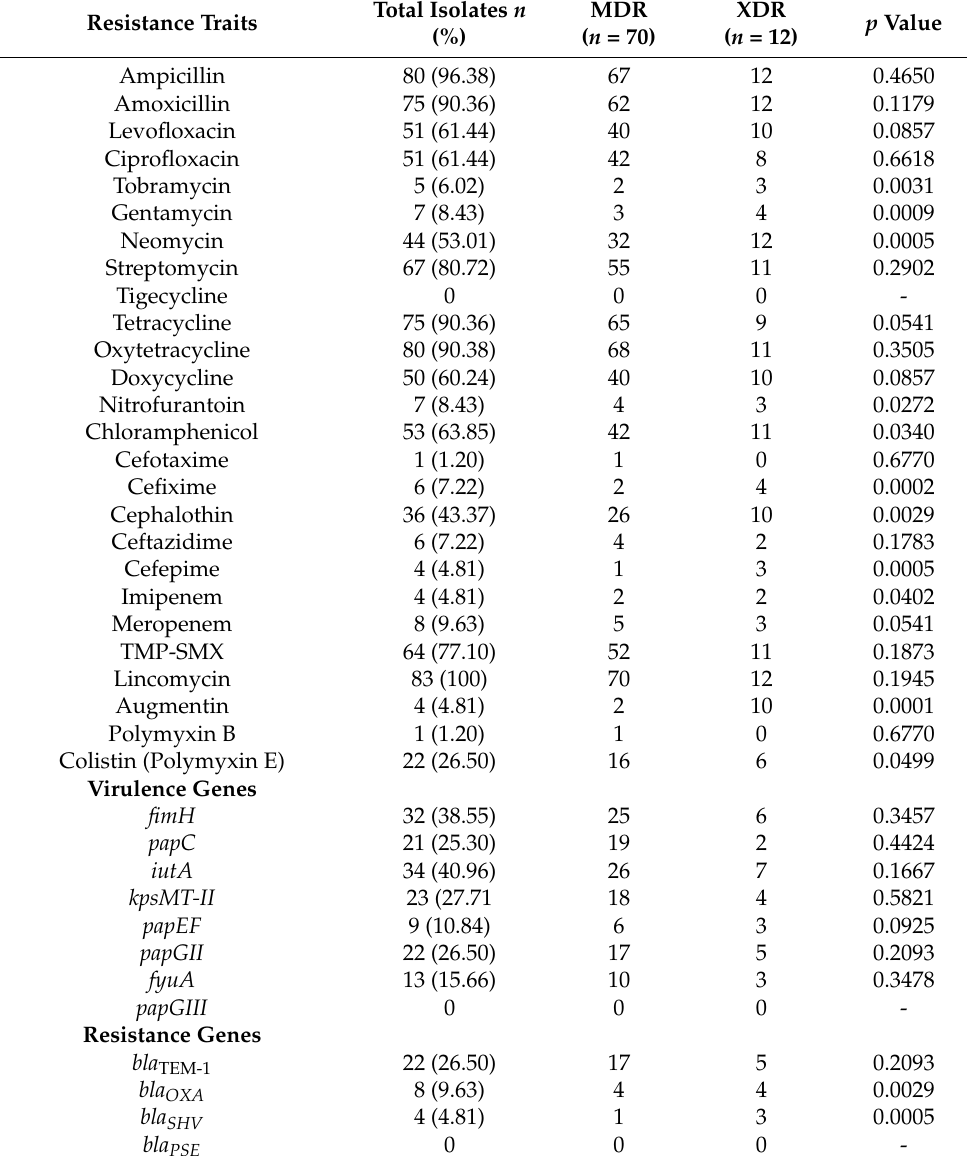
Table 1. Comparison of antibiotic resistant traits of MDR and XDR phenotypes of E. coli isolates ( n = 83). p values were calculated by chi-square